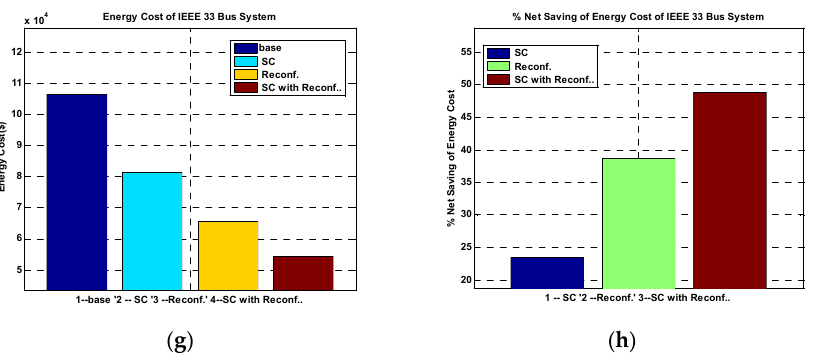
Figure 2. Performance of the 33-node test system with capacitor allocation only; the reconfiguration of the network only and the two approaches via the proposed algorithm: ( a ) Values of voltages at all buses; ( b ) values at different cases of the voltage deviation index; ( c ) values of voltage stability; ( d ) percentage of maximum voltage deviation; ( e ) power losses; ( f ) percentage of power losses saving; ( g ) energy cost; ( h ) percentage of energy cost-saving.